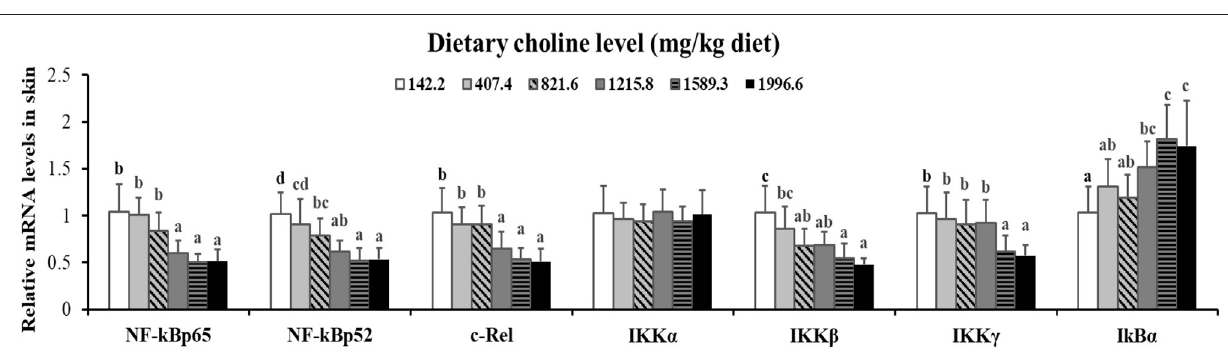
FIGURE 4 | Effects of dietary choline level (mg/kg diet) on relative expression of NF- κ B signaling molecules in skin of juvenile grass carp ( Ctenopharyngodon idella ) after infection with A . hydrophila . Data represent means of six fish in each group; error bars indicate S.D. Values having different letters are significantly different ( P <